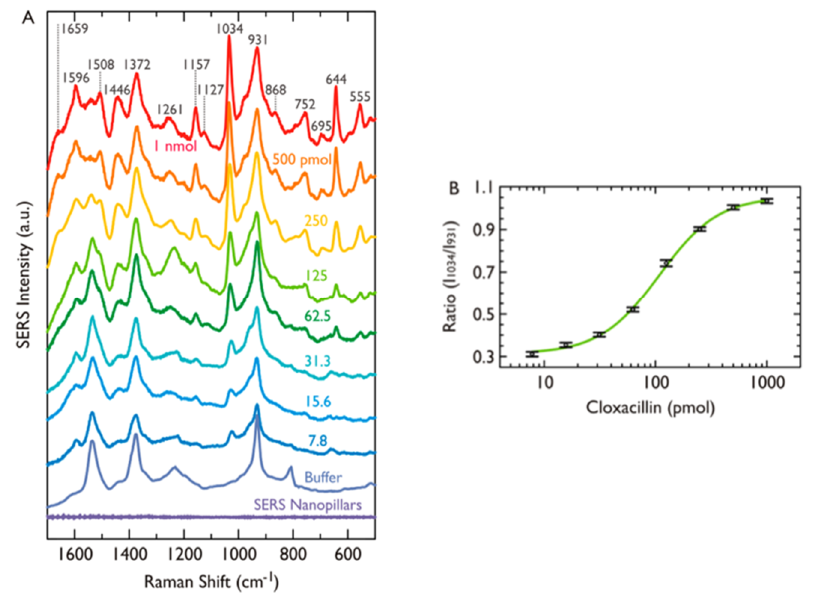
Figure 3. ( A ) SERS spectra for different amounts of cloxacillin deposited on the nanopillar substrate. SERS intensities were normalized to improve visual clarity. ( B ) The nonlinear calibration plot ( n = 3). Each ratio of intensity was averaged over 121 spectra obtained in a 1 mm × 1 mm droplet footprint. Reproduced with permission from [79]. Copyright 2017 American Chemical Society.